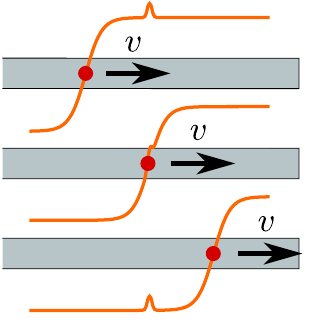
FIG. 6. In the comoving reference frame, static impurities effectively become time-dependent perturbations for the moving-domain-wall bound